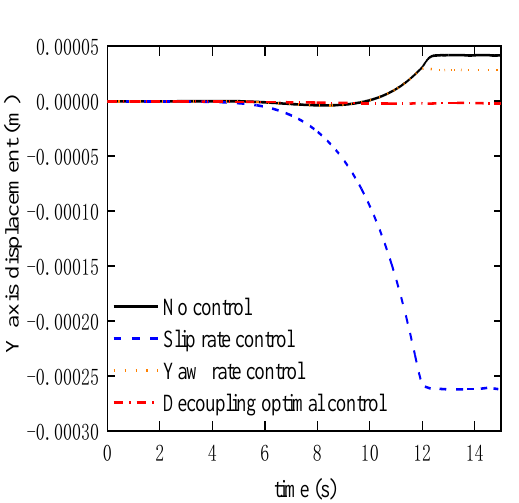
Figure 17. Yaw rate.